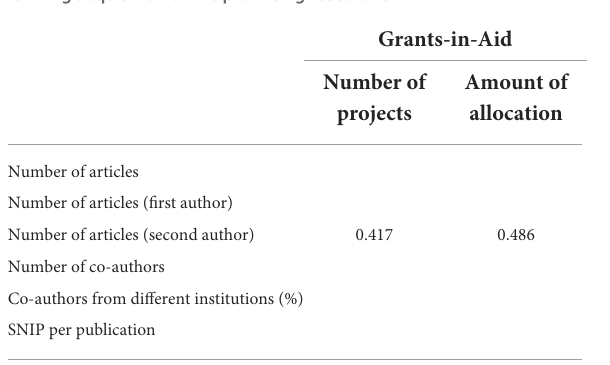
TABLE 4 Synchronic correlation between research performance and funding acquisition of the promising researcher.